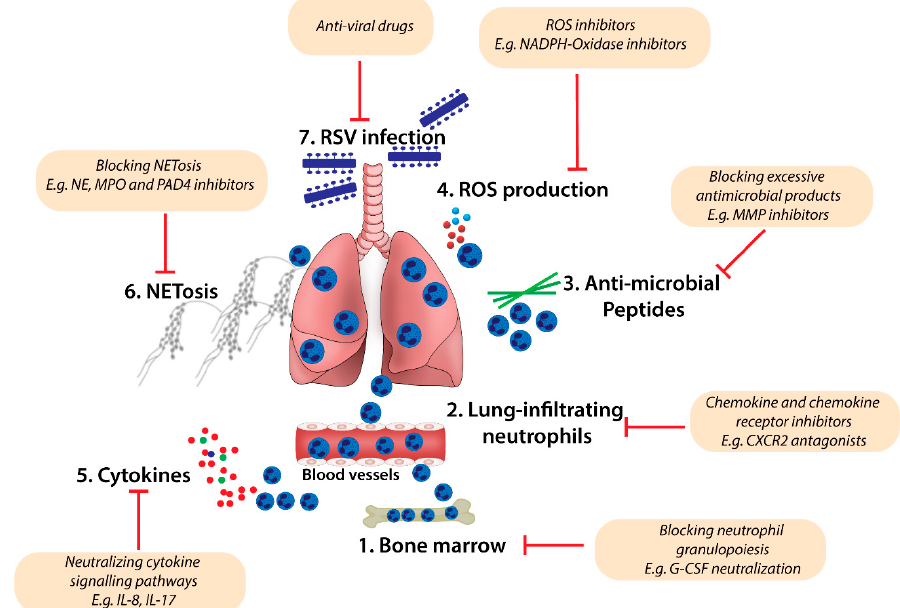
Figure 2. A schematic model for targeting excessive neutrophil homeostasis and function in RSV bronchiolitis. Pharmacological inhibition of excessive neutrophil maturation, recruitment into lung tissues, and e ff ector function may improve the treatment of severe RSV bronchiolitis. Therapeutic inhibition strategies may aim to: (1) block excessive neutrophil granulopoiesis in the bone marrow (e.g., neutralising G-CSF production and function); (2) antagonise chemokine-mediated neutrophil activation and chemotaxis to the lung microenvironment (e.g., using CXCR2 small